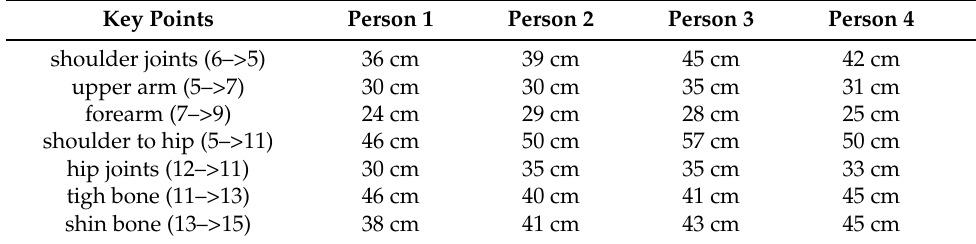
Table 2. Manual measurements of the keypoints.